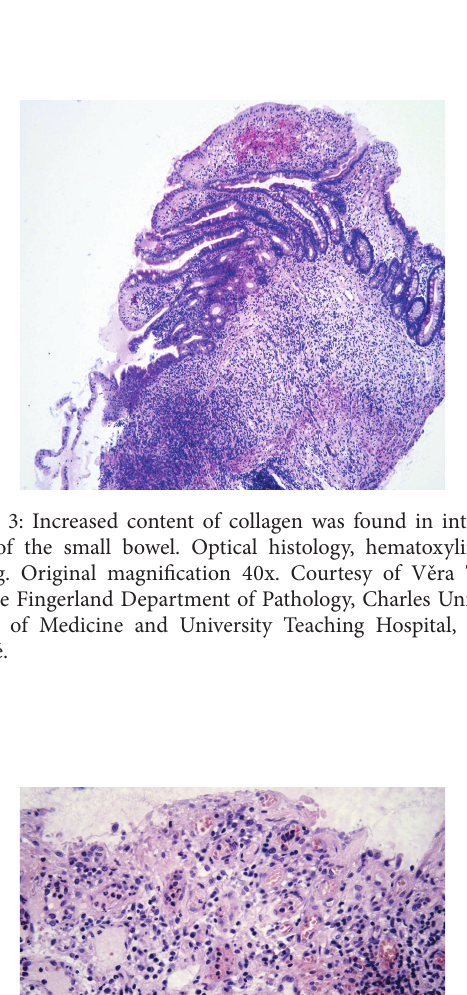
Figure 2: Double balloon enteroscopy. A large but shallow ulcer is seen in front of tight fibrous stricture of the distal jejunum.